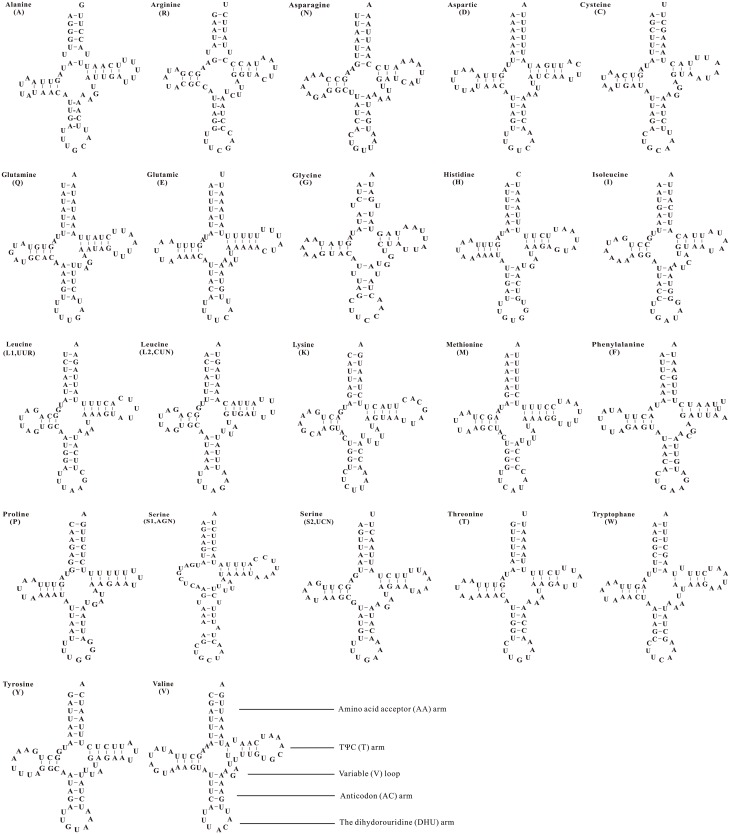
Inferred secondary structure of tRNAs in the Delia antiqua mitochondrial genome.The tRNAs are labeled with their corresponding amino acids.